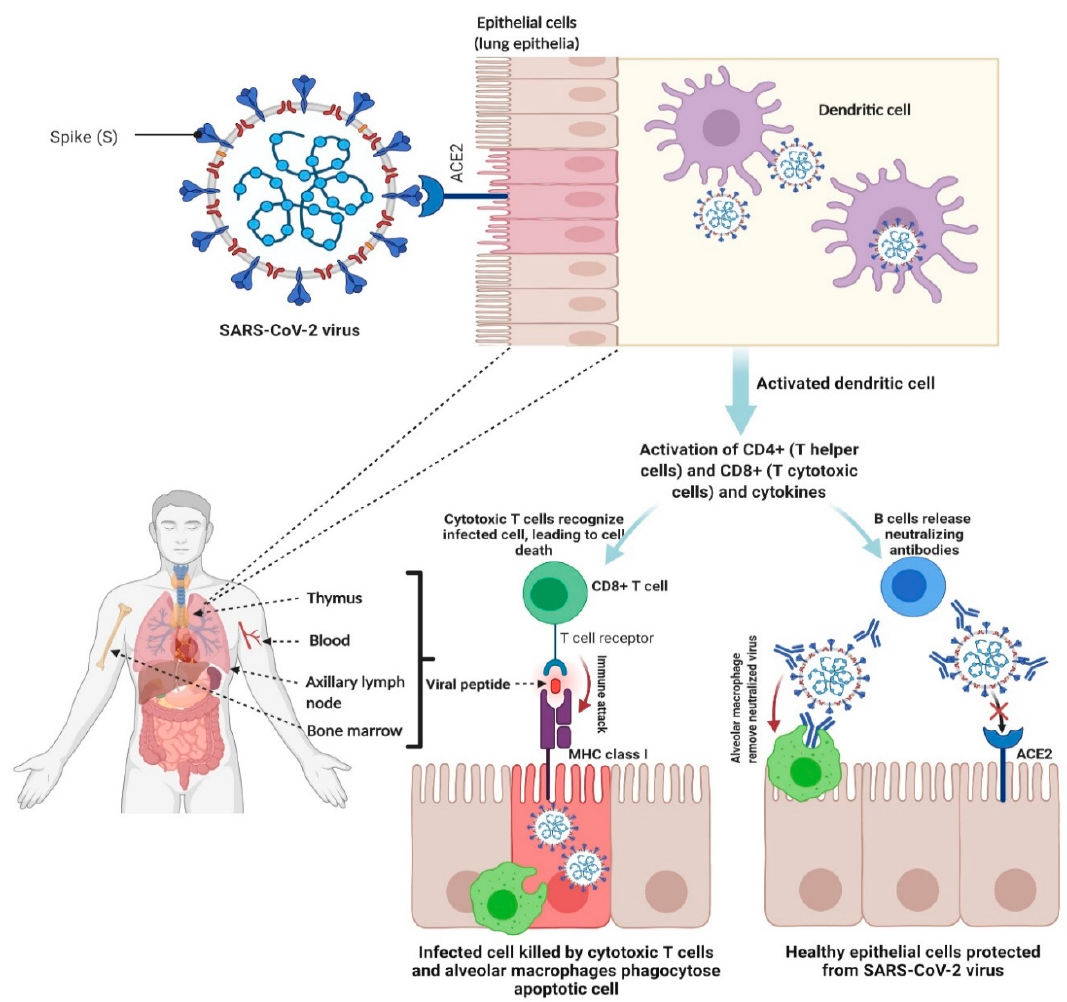
Figure 1. Schematic illustration of adaptive immune response in COVID-19, where B and T-cell responses are important in preventing SARS-CoV-2 infection and destroying infected cells. Figure was created with biorender.com (accessed on 9 March